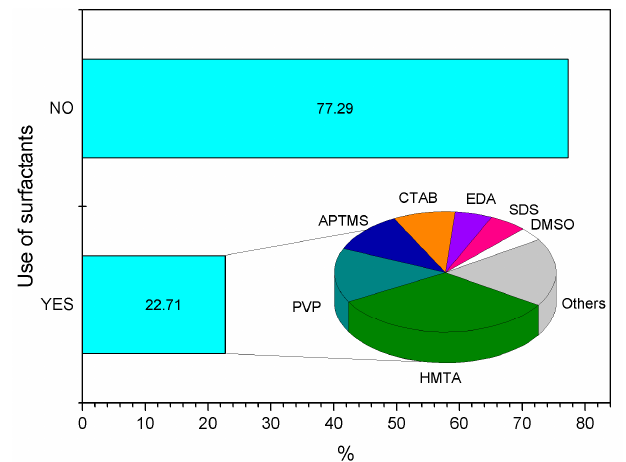
Figure 14. Main surfactants used on ZnO–graphene